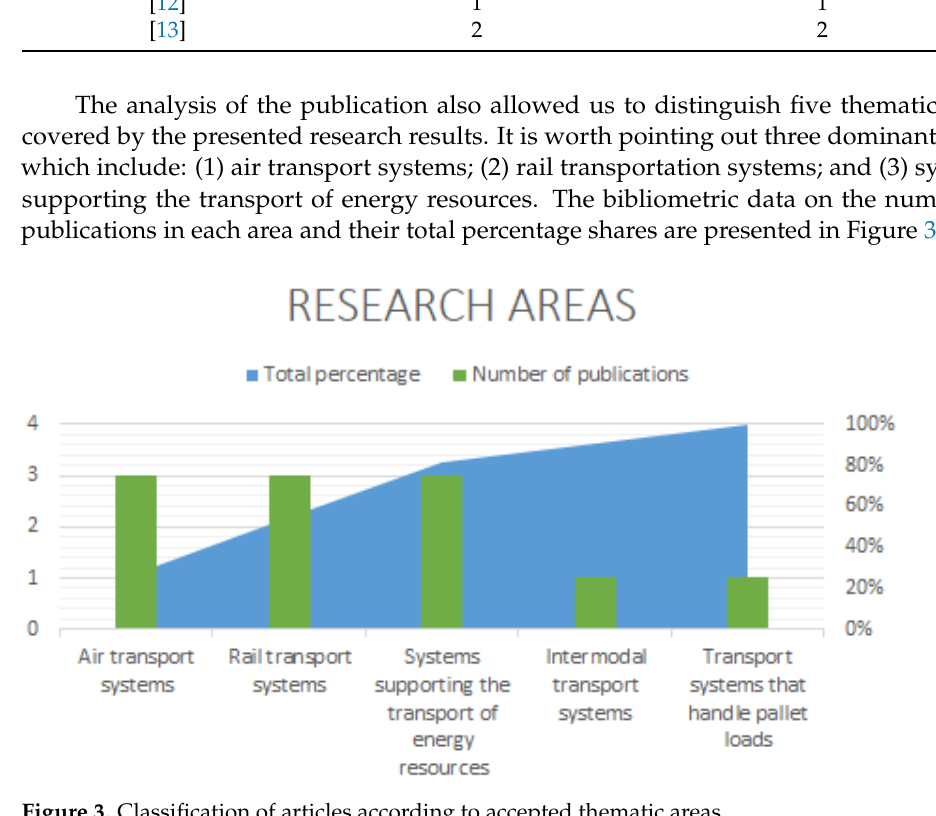
Figure 3. Classi fi cation of articles according to accepted thematic